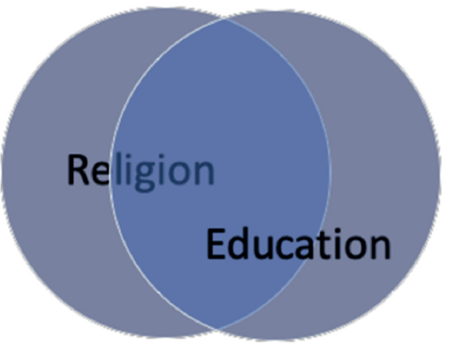
Figure 2. Education about religion and the civic purpose of religious education.